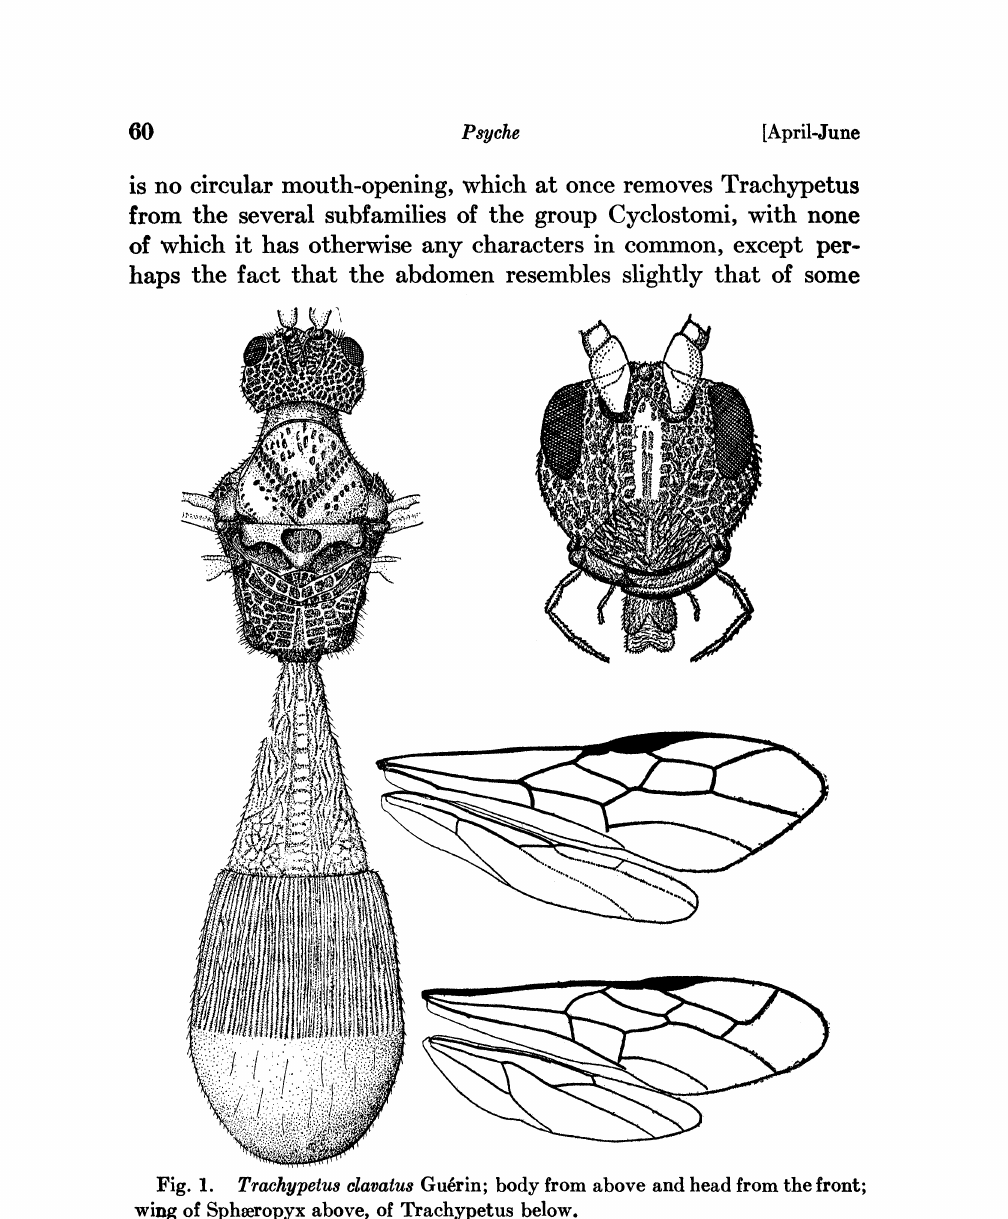
Fig. 1. Trachypetus davatus Gu6rin; body from above and head from the front; wing of Spheropyx above, of Trachypetus